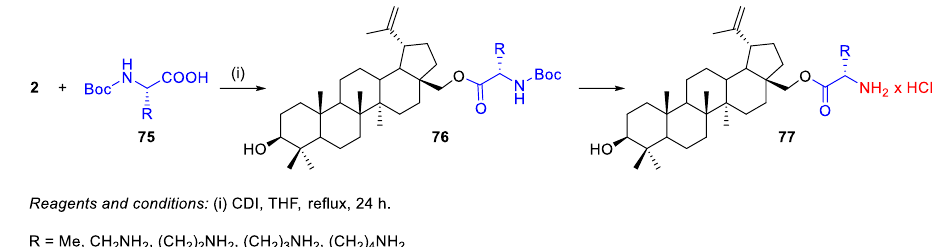
Scheme 12. Synthesis of monosubstituted BN esters containing L -amino acids 77